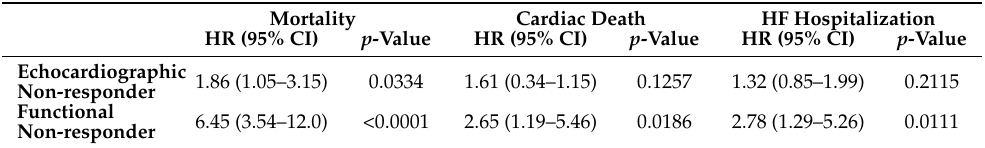
Table 5. Cox regression analysis of all-cause mortality, cardiac death, and hospitalization for both echocardiographic and functional